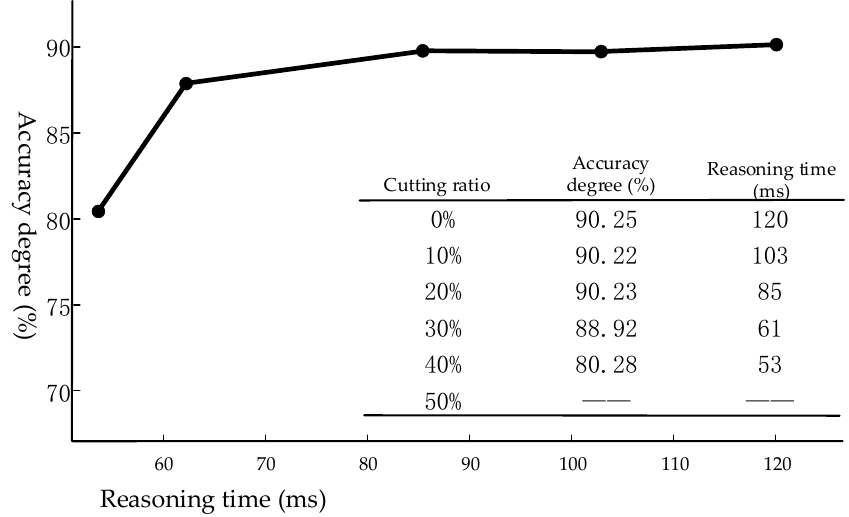
Figure 18. Comparison of experimental results for different cutting ratios .